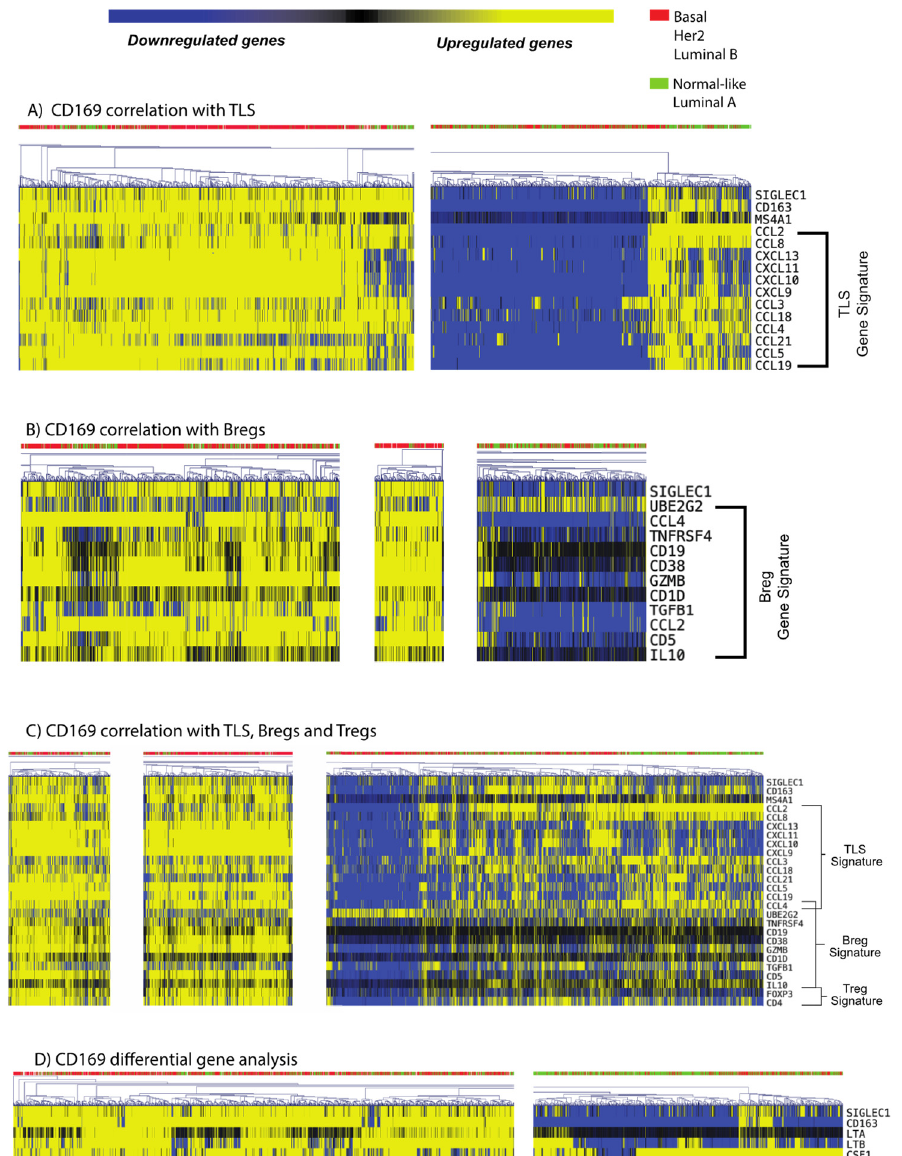
Figure 4. Heat map associations between SIGLEC1 (CD169) and gene signatures for ( A ) tertiary lymphoid structures (TLSs), ( B ) Bregs and ( C ) Tregs. Patients are characterized based on their molecular subtype of breast cancer, aggressive subtypes in red (basal-like, HER2 + and luminal B), and luminal A or normal-like subtypes in green. Upregulated genes are shown in yellow while downregulated genes are shown in blue. The threshold for upregulation/downregulation was set at 1/-1 based on median- centered genes relations. The highlighted areas represent clusters with positive cell infiltration, taken from full-scale analysis shown in Supplementary Figure 4. ( D ) SIGLEC1 (CD169) was correlated with the CD169 + macrophage differentiation markers CD163, LTA, LTB and CSF1.